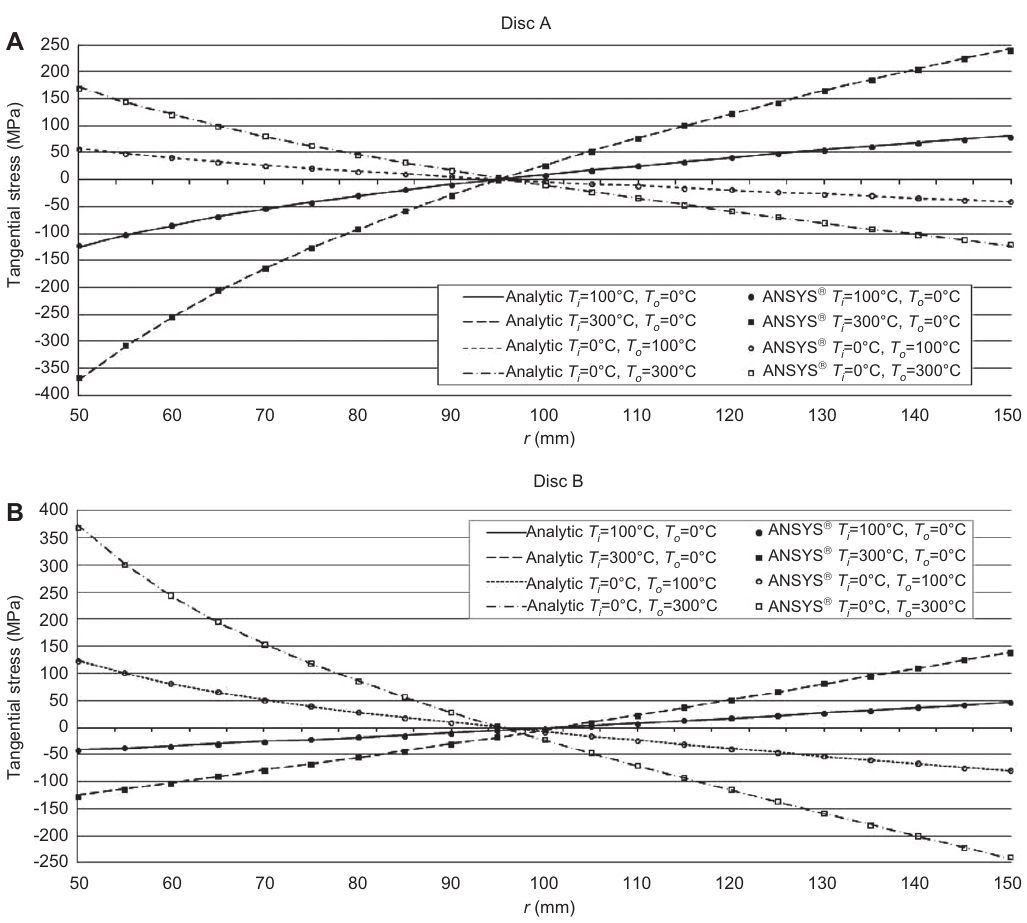
Figure 7 Variations of tangential stresses at Disc A (A) and Disc B (B) under linearly increasing and decreasing